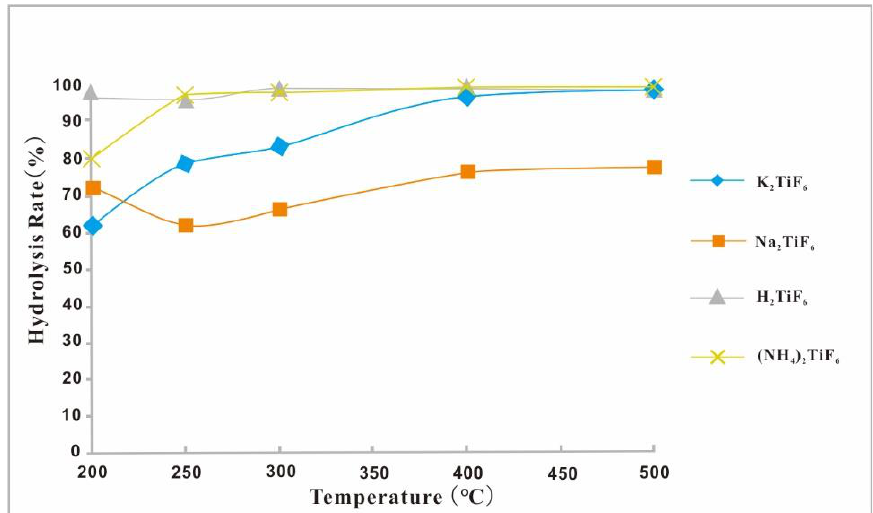
Figure 1. Hydrolysis curve of different F-Ti complexes for various temperatures at 100 Mpa.